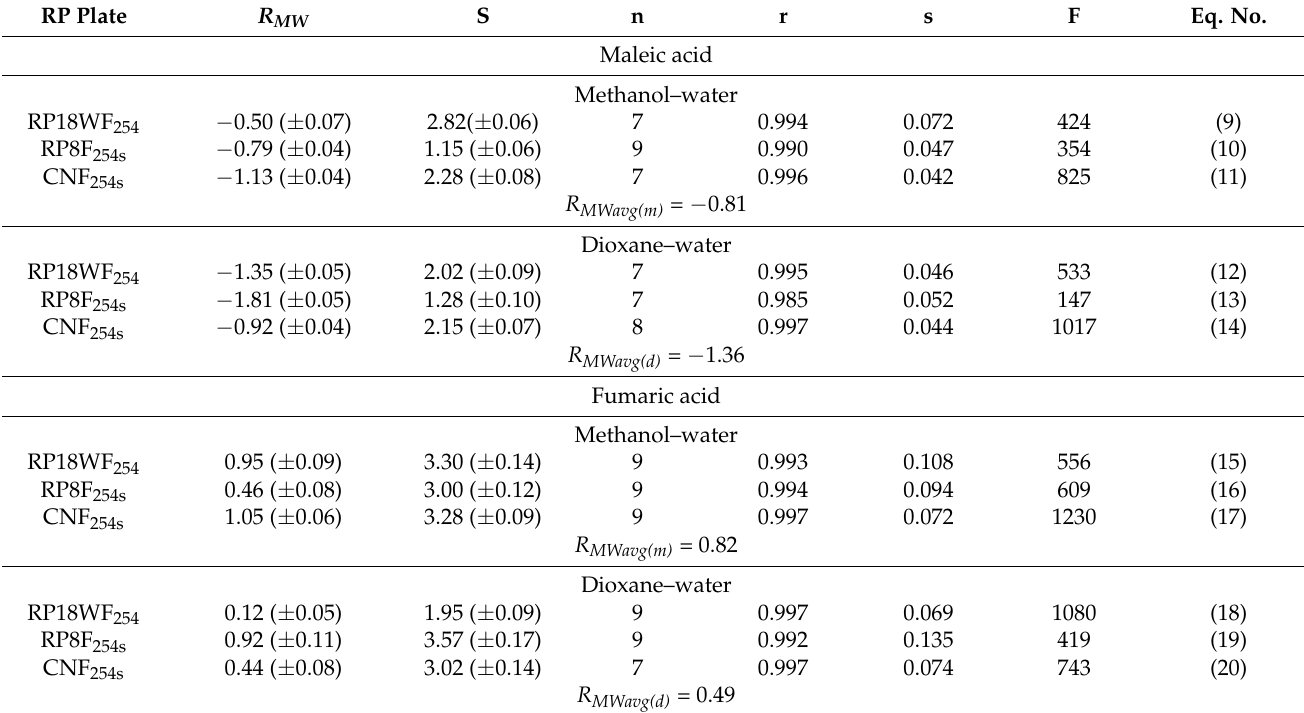
Table 4. Lipophilicity parameter ( R MW ) obtained on RP plates using two mobile phases, and com- puted using the Soczewi´nski–Wachtmeister equation: R M = R MW – S · ϕ .